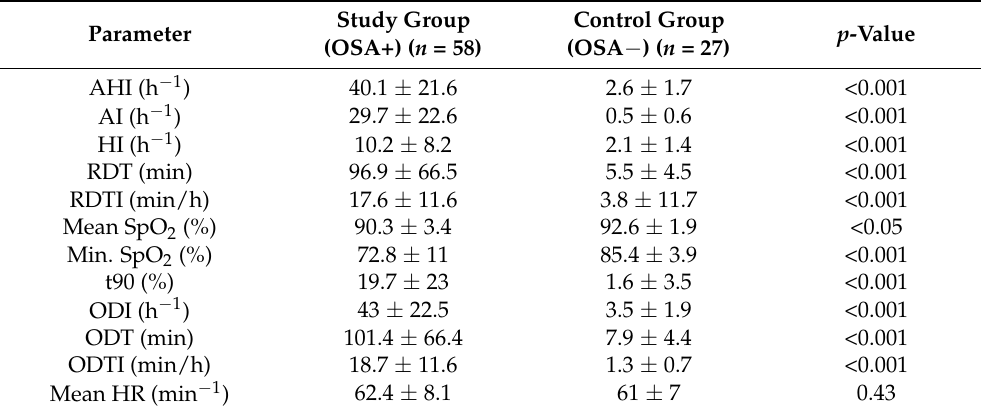
Table 2. Polygraphy results in the study (OSA+) and control (OSA − )